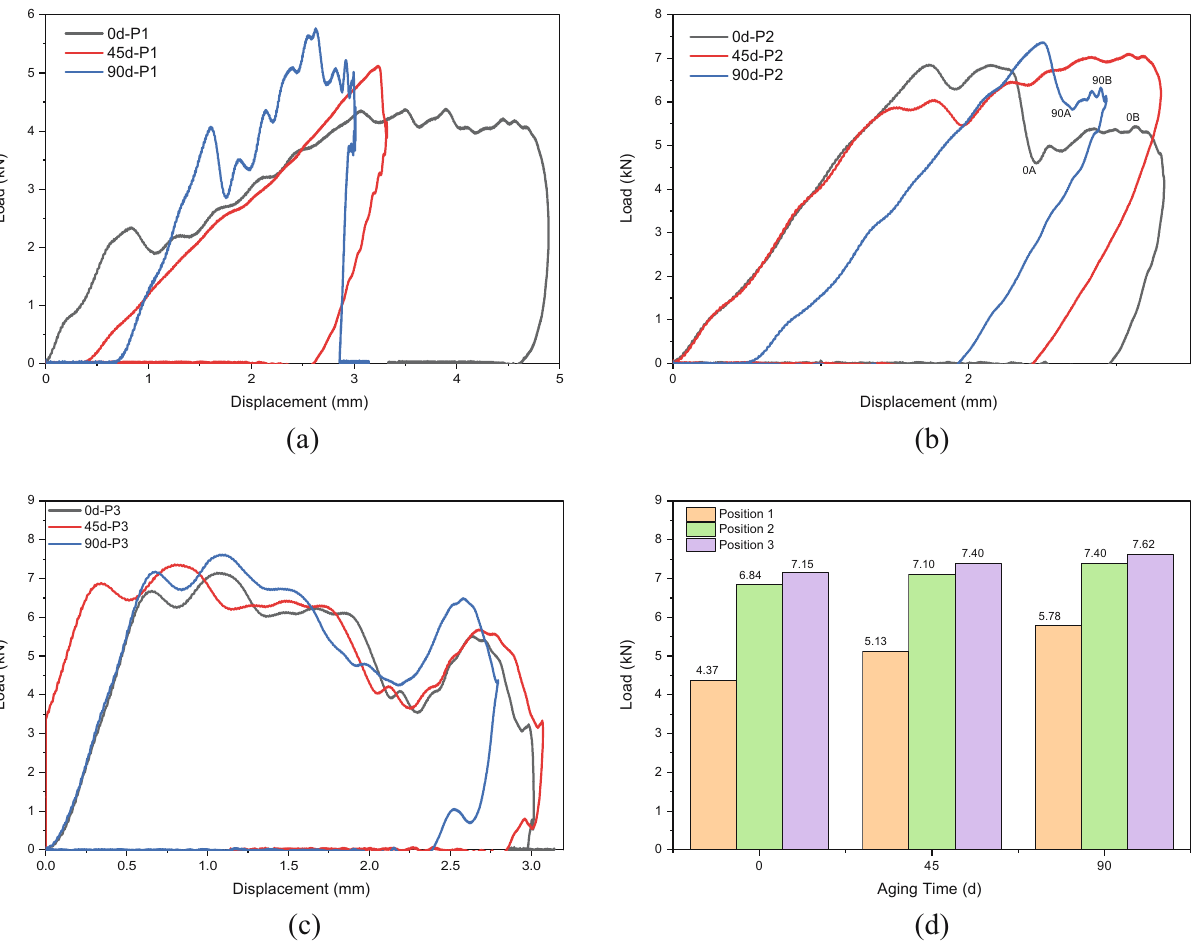
Figure 4: Impact response curves of specimens: ( a ) located at position 1; ( b ) located at position 2; ( c ) located at position 3; and ( d ) peak